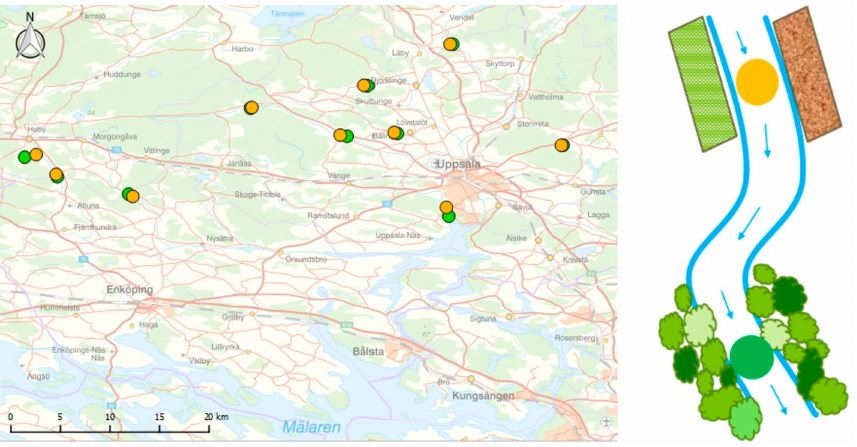
Figure 1. Position and schematic representation of streams and their paired reaches (orange dots— upstream unbuffered reaches; green dots—downstream forested buffered